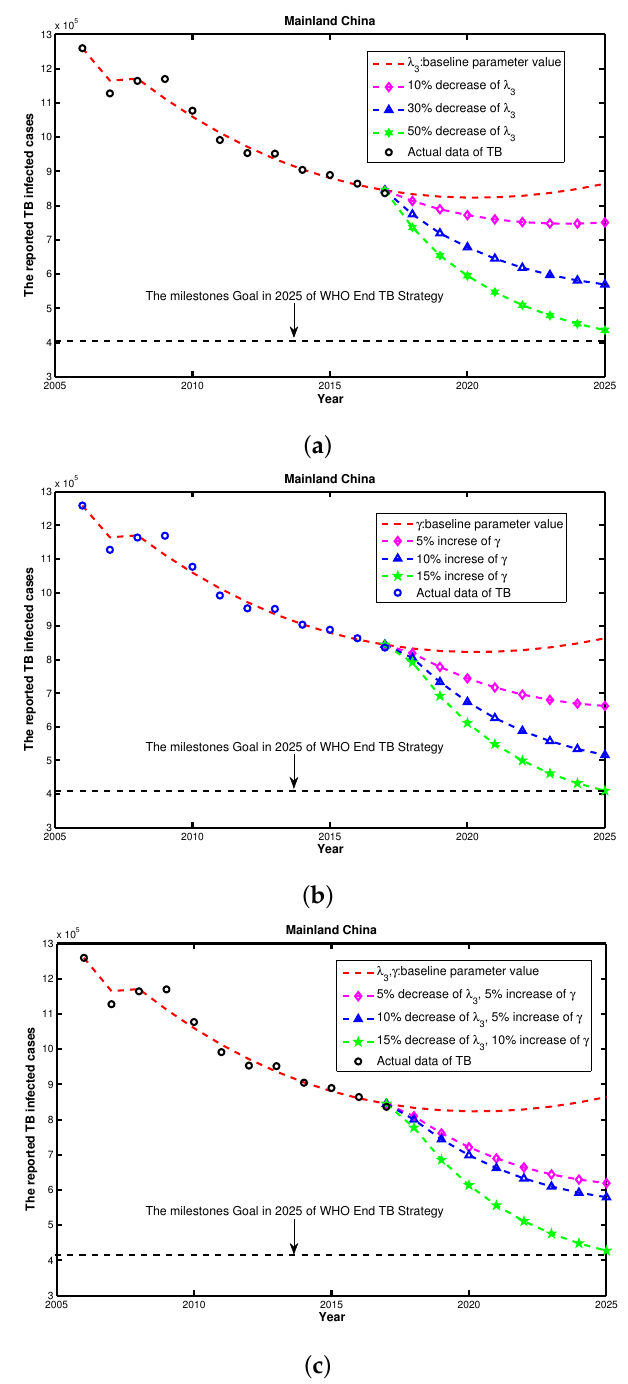
Figure 7. The reported TB cases ( a ) under control strategies of decreasing λ 3 from 1 to 0.5; ( b ) under control strategies of increasing γ from 1 to 1.15; and ( c ) under a combination of control strategies of increasing γ from 1 to 1.1 and decreasing λ 3 from 1 to 0.85,